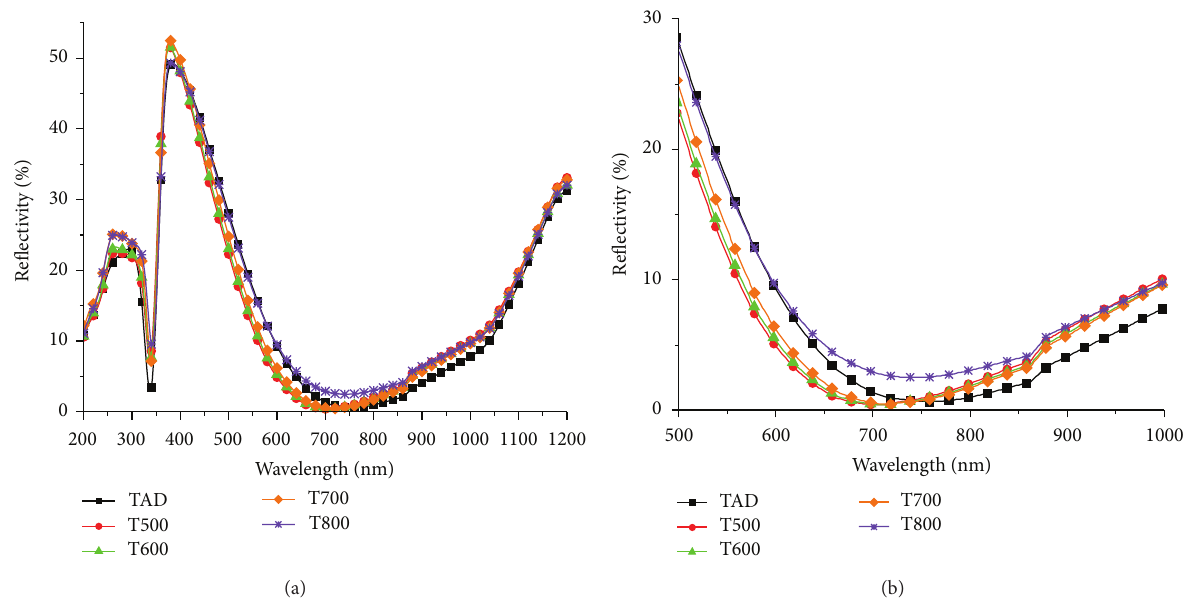
Figure 9: Total hemispherical reflectivity for all samples under study. The right figure is an enlarged view of the reflectivity curve over the wavelength range of